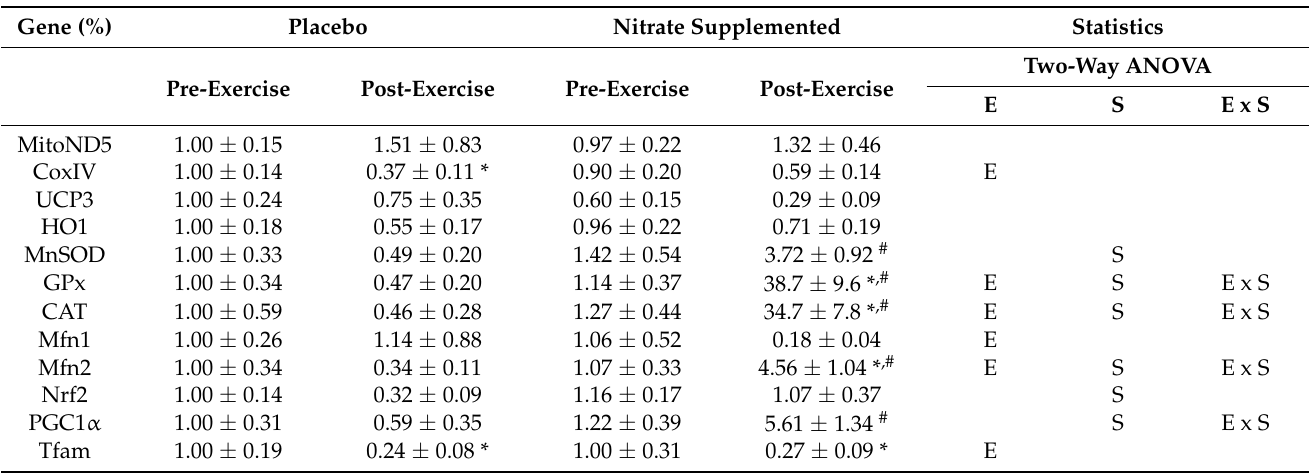
Table 3. Effects of exercise and nitrate supplementation on mitochondrial and antioxidant gene expression in PBMCs of metabolic syndrome